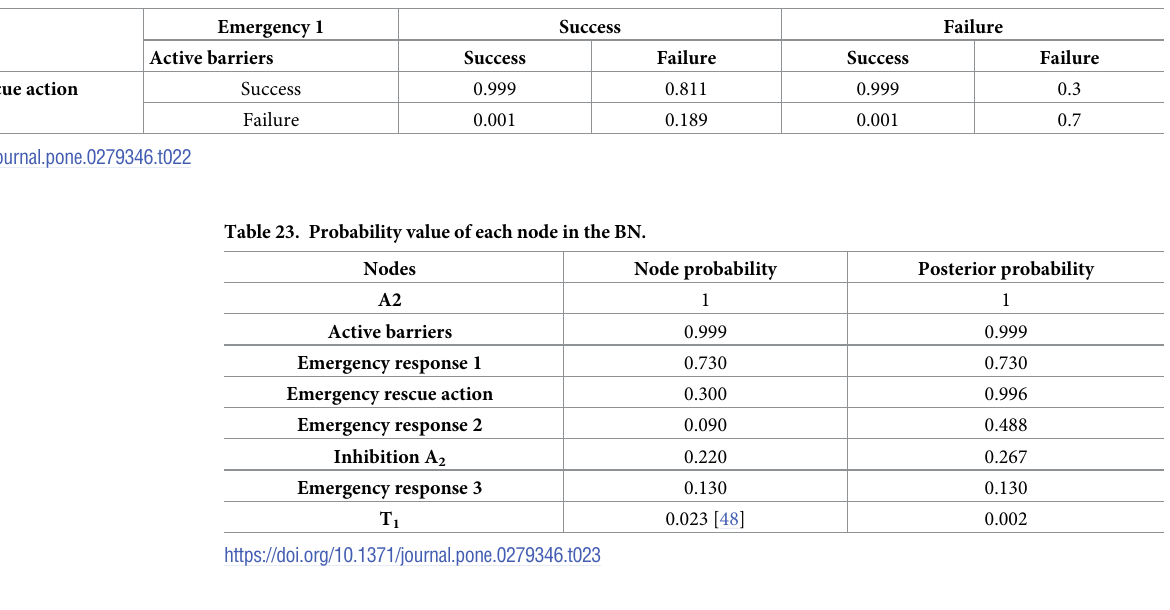
Table 22. An example of CPT of emergency rescue action.